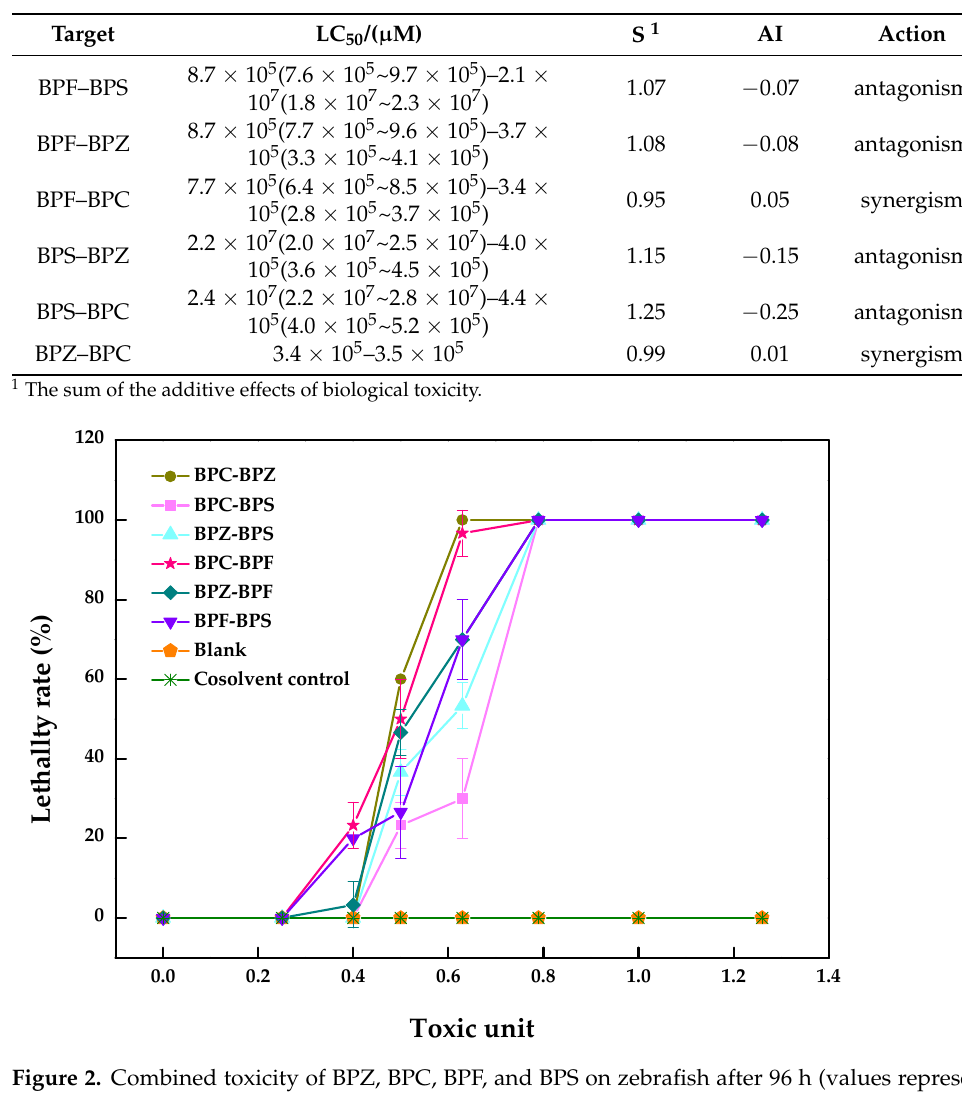
Table 3. Multi-joint acute toxicity of BPZ, BPC, BPF, and BPS on zebrafish after 96h. Target